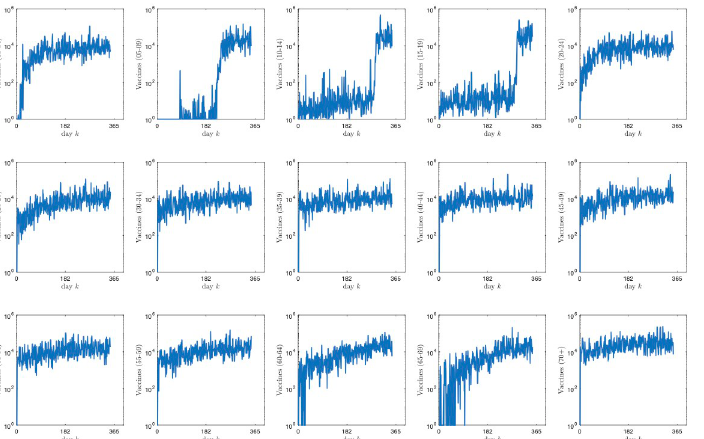
Fig 5. Intervention plan corresponding to the found solution in terms of the units of vaccines administered to the different age classes for each day.